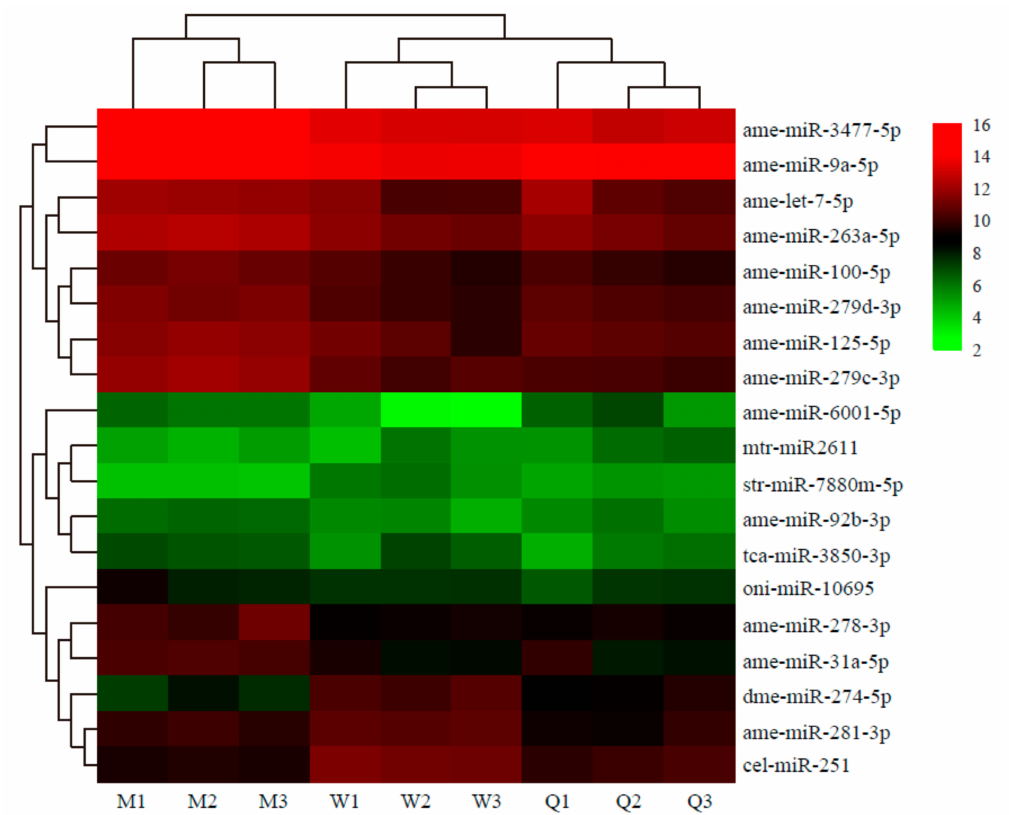
Figure 3. Heat map diagram showing the di ff erentially expressed miRNAs (DE miRNAs) in the three B. lantschouensis castes. Nineteen di ff erentially expressed miRNAs with | fold change | ≥ 1 and p < 0.05 were screened using the DESeq R package. The rows represent the di ff erent miRNAs, and the columns represent males (M1, M2, M3), workers (W1, W2, W3), and queens (Q1, Q2, Q3). The expression data for each miRNA were calculated from three biological